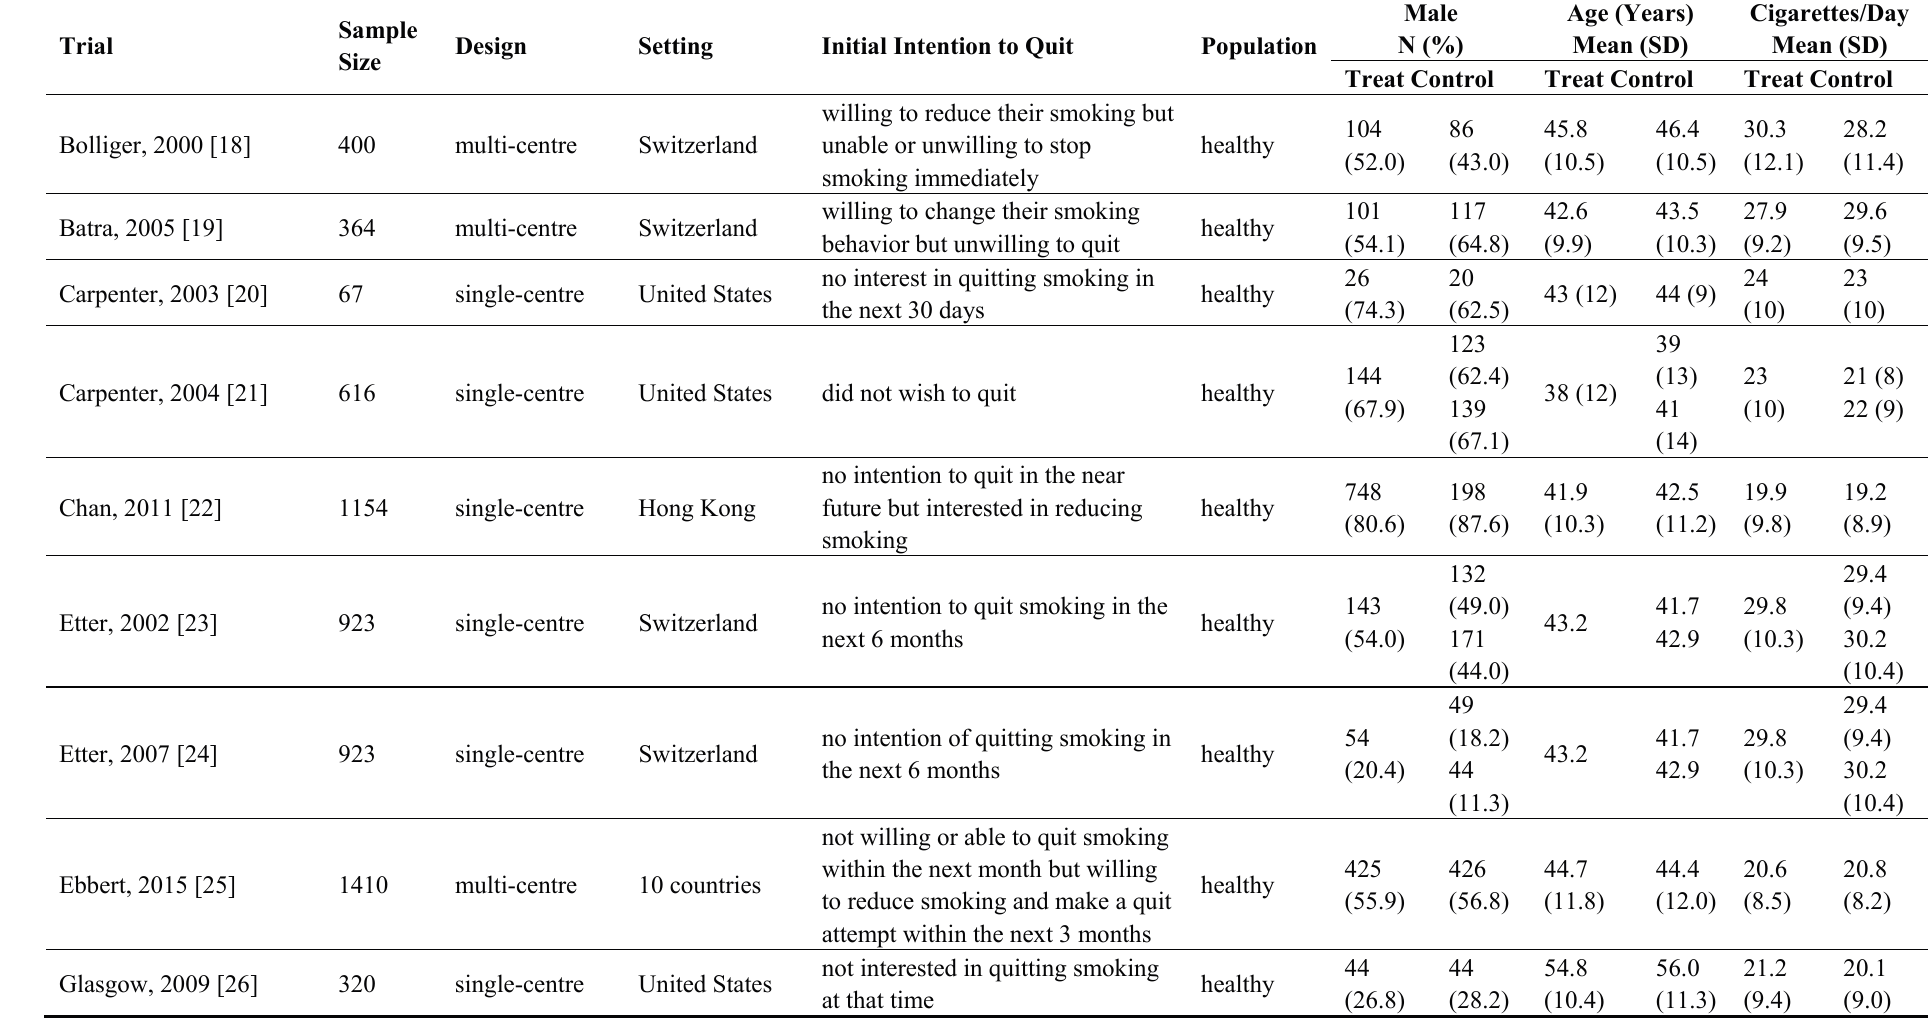
Table 1. Characteristics of the included